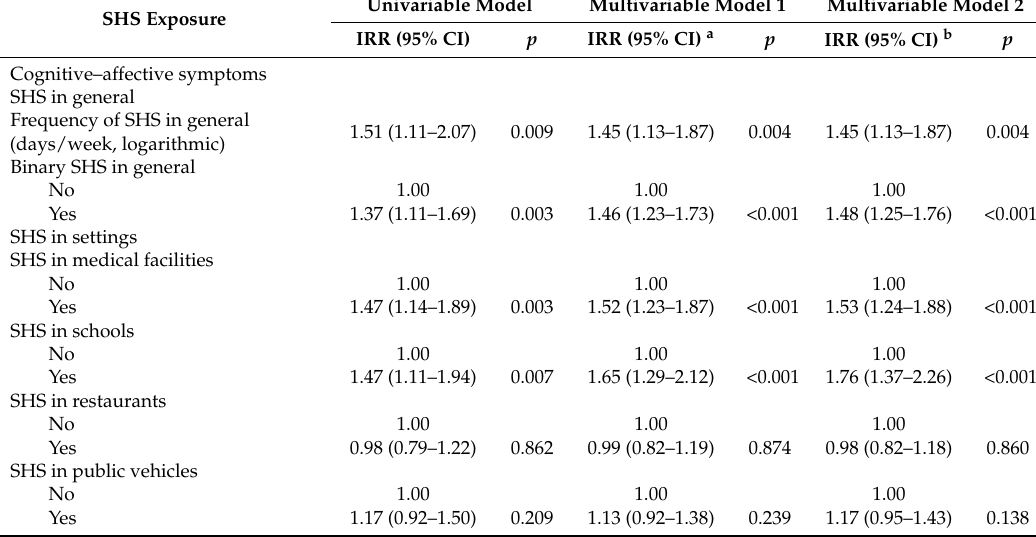
Table 3. Association between SHS exposure and depressive symptoms stratified by two dimensions. SHS